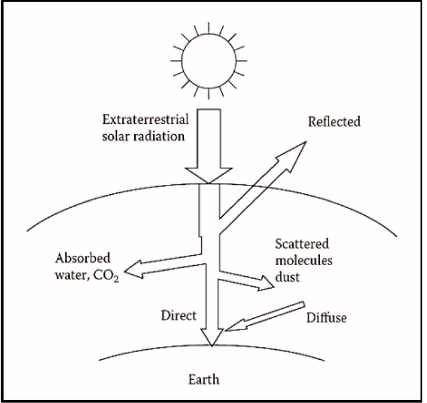
Figure 3. Attenuation of solar insolation as it passes during the atmosphere [16].